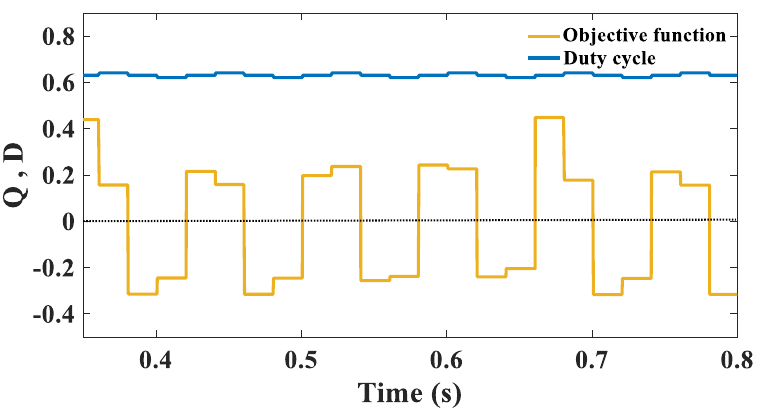
Figure 12. Oscillation of Q around zero during MPP tracking.